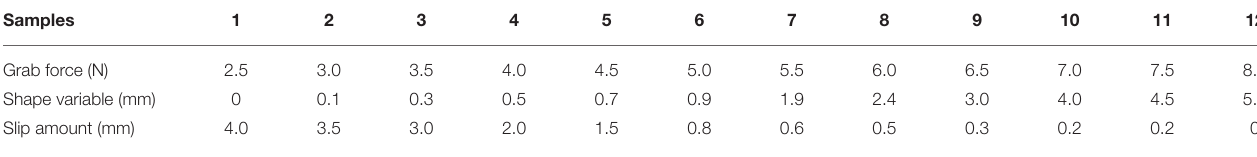
TABLE 3 | Experimental data of grasping force, component shape variables and slip amount. Samples